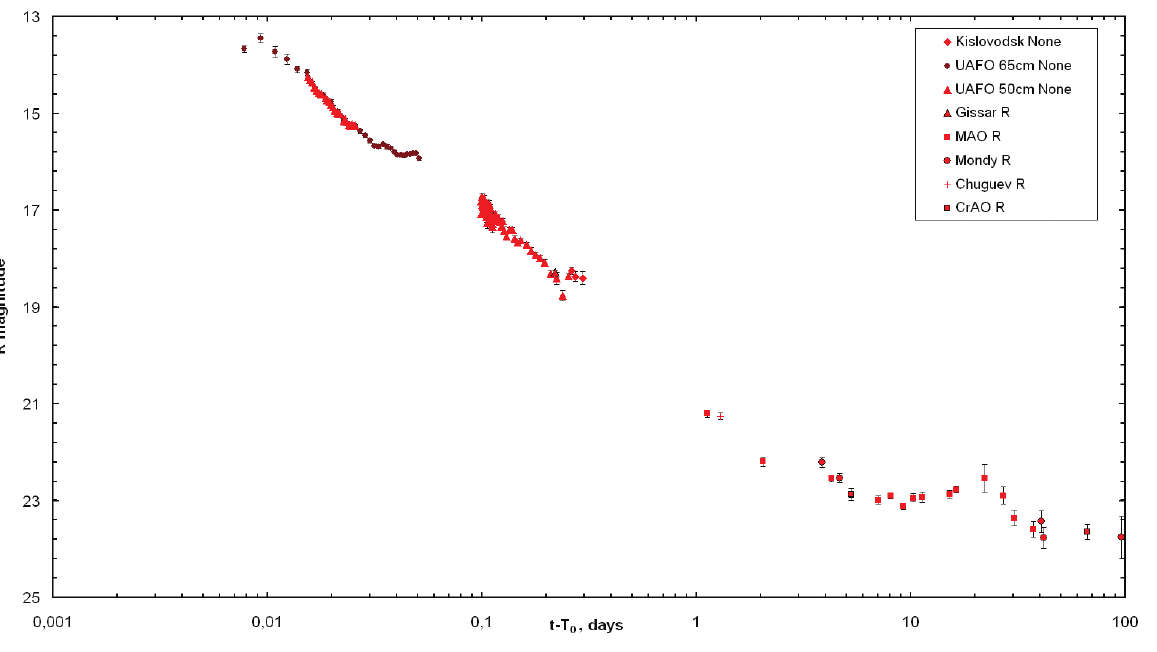
Figure 5. Optical light curve of GRB 130831A afterglow and associated SN 2013fu, constructed using IKI GRB-FuN observations in R